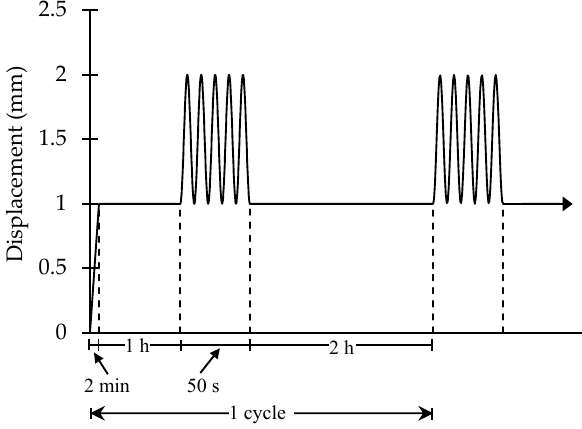
Figure 5. Loading pattern used on cell ‐ seeded scaffold.